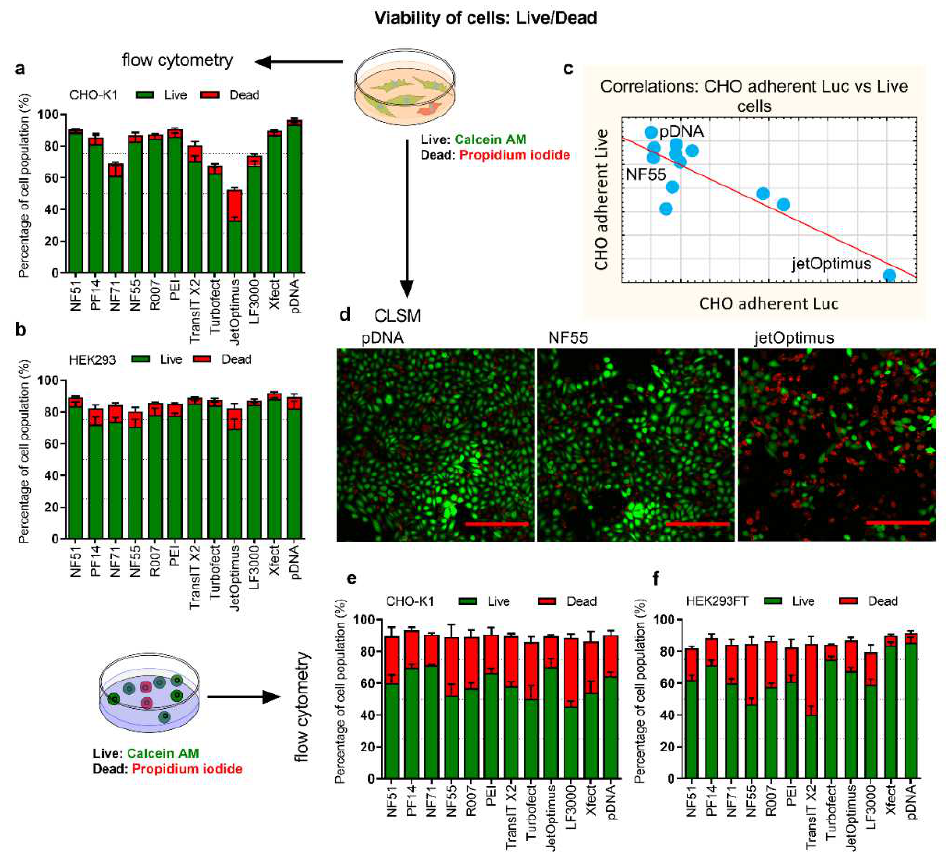
Figure 4. Cell viability post-transfection was assessed by the live/dead assay. Adherent ( a ) CHO-K1 cells and ( b ) HEK293 cells were transfected with 0.5 µg of pLuc per 24-well plate well. CPP/pDNA complexes were formed at CR3:1, and PEI complexes at N/P20. Analysis was done 24 h post- transfection. Calcein AM (live) and PI (dead) were added to detect live and dead cells. ( c ) The correlation graph depicting correlations between luciferase expression levels against viability of cells in adherent cell experiments. ( d ) The representative confocal images of cells 24 h post-treatment with pDNA, and cells transfected using jetOPTIMUS (jetOptimus) or NF55 (NF55). The red bar corresponds to 200 µm. Suspension ( e ) CHO K1 and ( f ) HEK293FT cells were transfected in serum-free media with 0.75 µg of pSEAP. CPP/pDNA complexes were formed at CR2:1, and PEI/pDNA at N/P20 (HEK293FT) or N/P60 (CHO-K1). 48 h post-transfection cells were collected, and Calcein AM and PI were added to detect live and dead cells from the whole cell population. N ≥ 3.